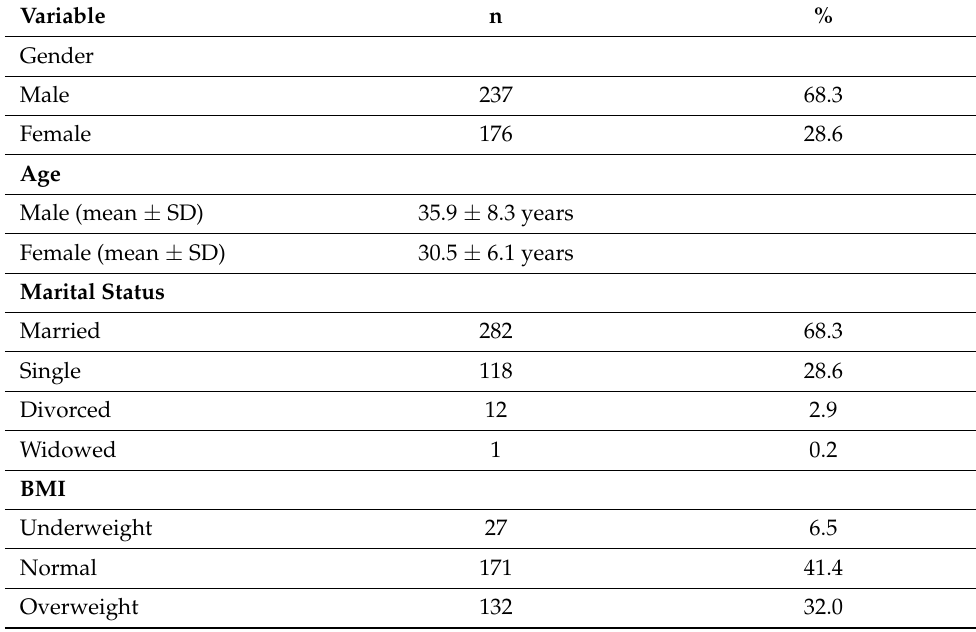
Table 1. Demographic characteristics of the participants (Total number =